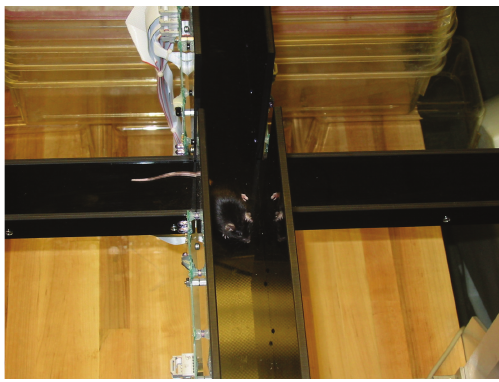
Figure 1: Elevated plus maze: the mice are tested for 10 minutes; while they are curious to explore the open areas, they are anxious to do